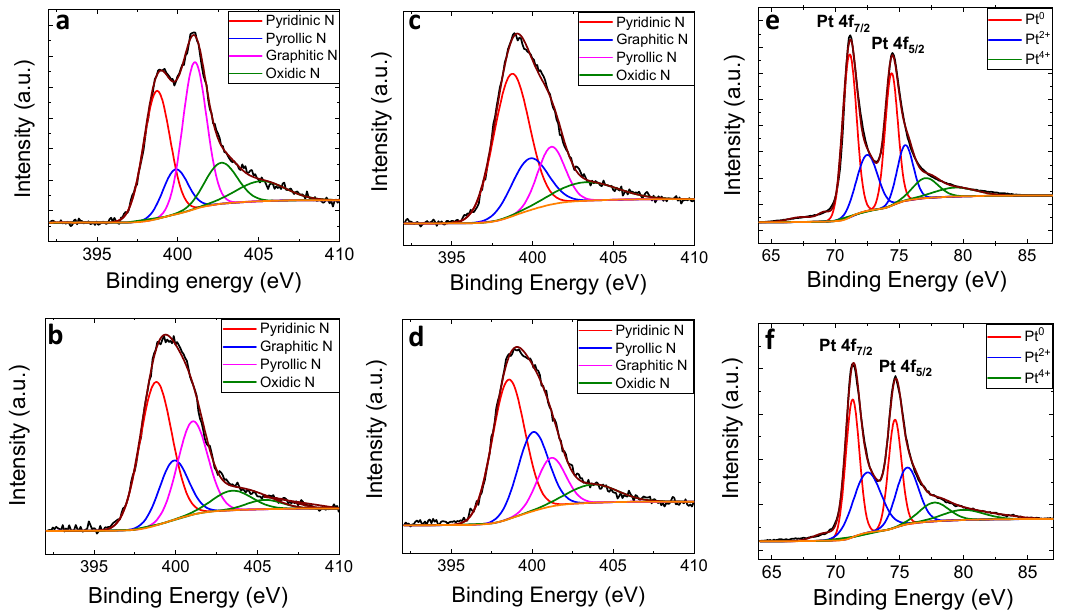
Figure 2. N 1s XPS spectra of ( a ) bare VACNF, ( b ) N-VACNF PA 5 min, ( c ) N-VACNF PA 15 min, and ( d ) N-VACNF PA 30 min; Pt 4f XPS spectra for ( e ) Pt/N-VACNF and ( f ) Pt/C.